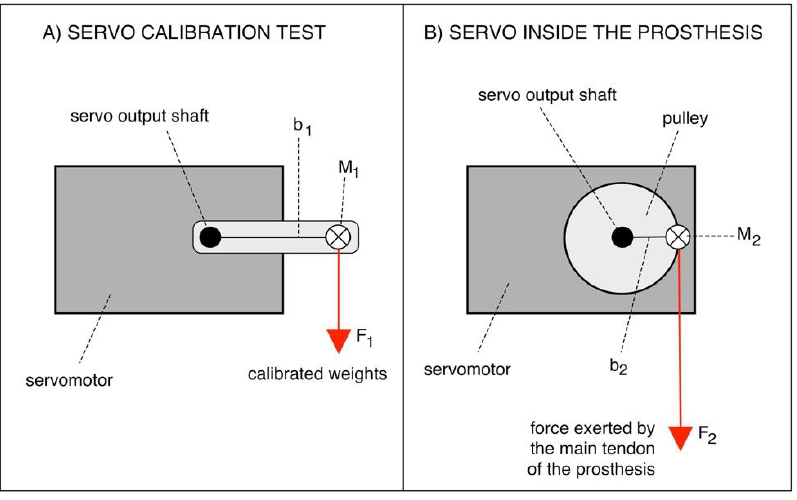
Figure 8. Servomotor configurations: ( A ) Calibration test; ( B ) Implementation in the prothesis.